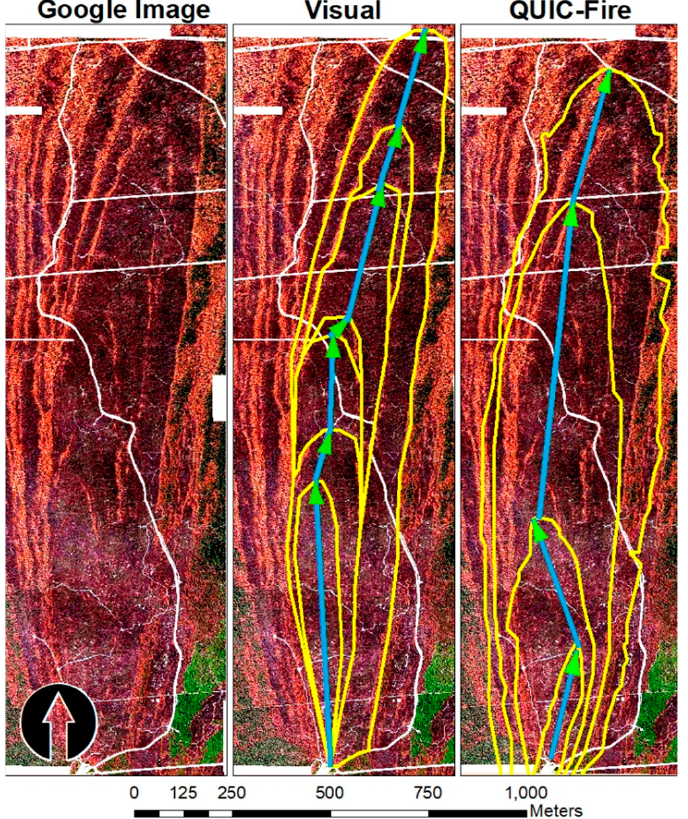
Figure 5. Comparison of visually estimated fire path of progression based on fire suppression staff observations and patterns in tree crown streets visible in post-fire Google imagery, and QUIC-Fire estimated progression (e.g., simulation scenario S0).